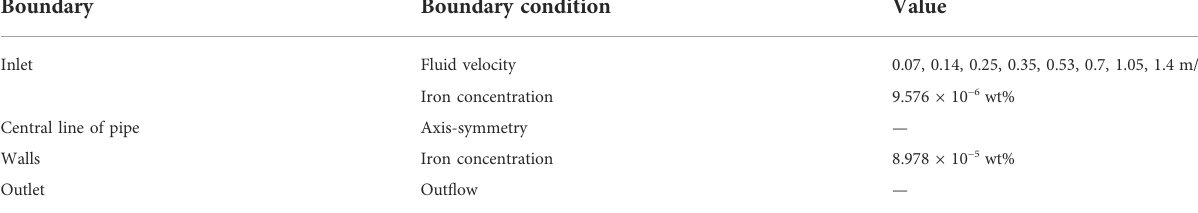
TABLE 2 Boundary conditions used in